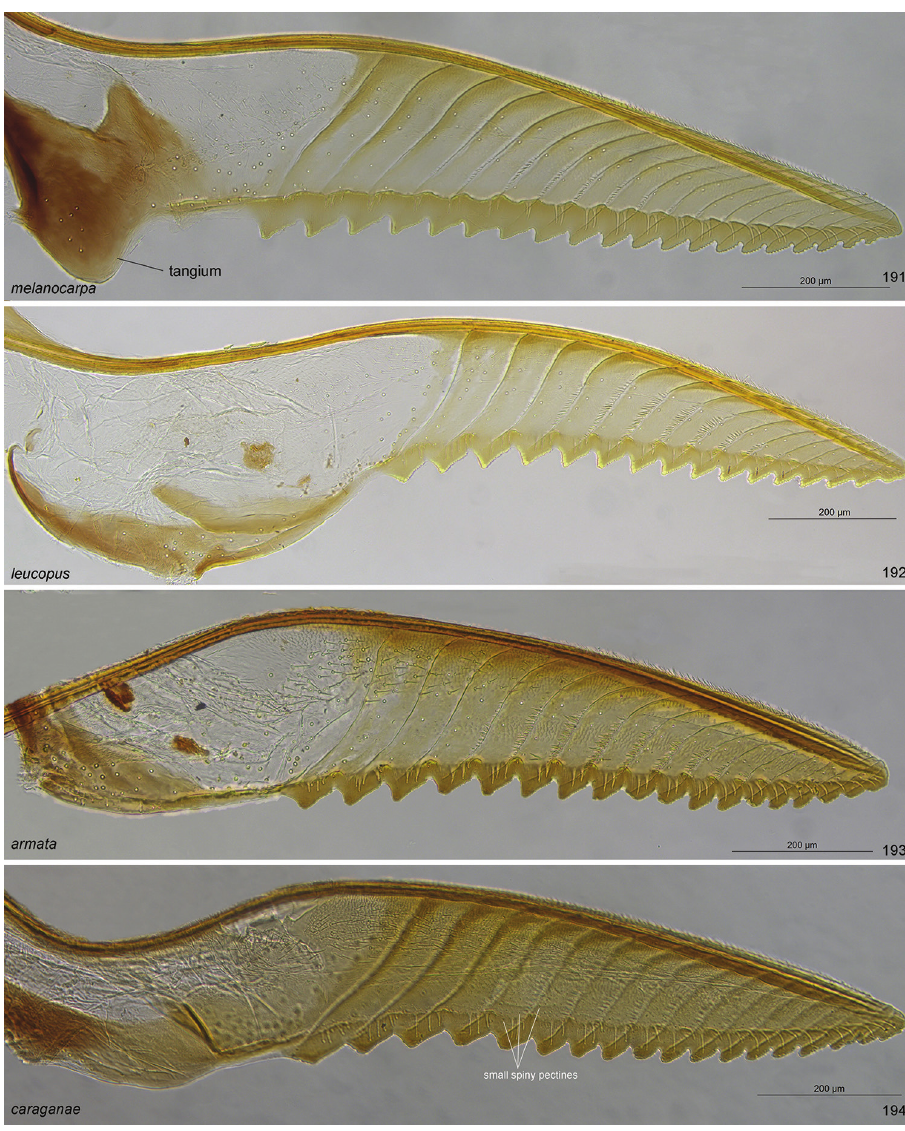
Figures 191–194. Lancets of Pristiphora . 191 melanocarpa PR.423VV 192 leucopus